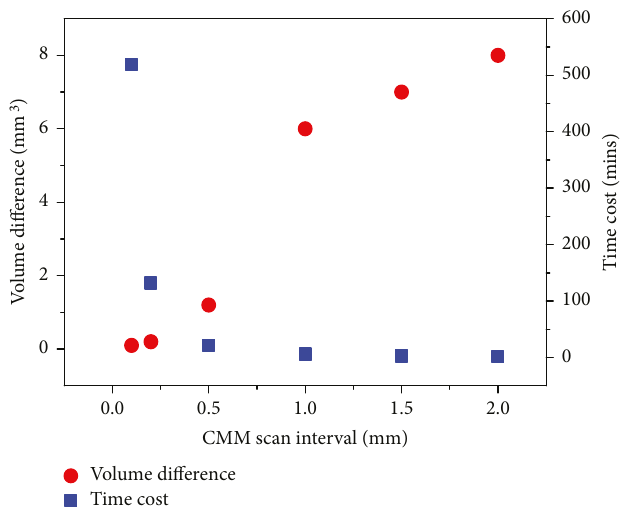
Figure 5: The in fl uence of CMM scan interval on volume di ff erence.